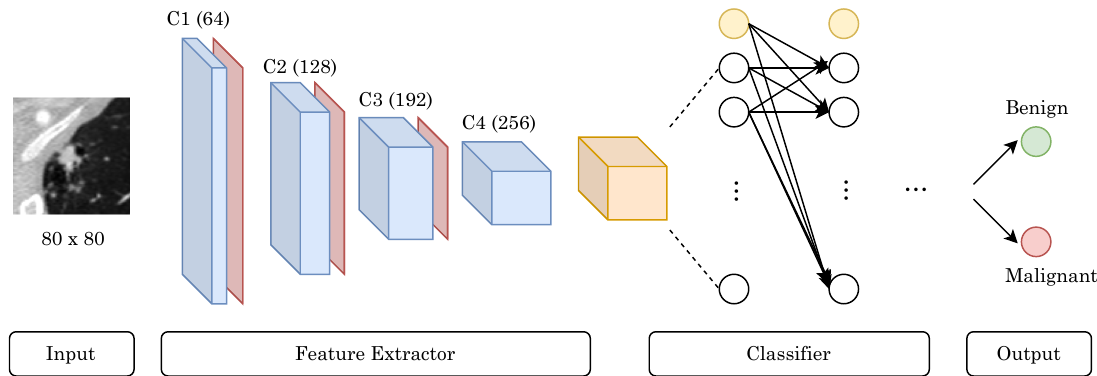
Figure 2. Pipeline developed for lung nodule malignancy classification composed by the feature extractor (CAE encoder) followed by a